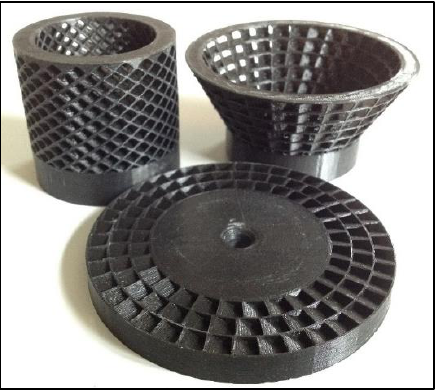
Figure 8. Mesh turbine impeller prototypes: on the left in the background - a cylindrical centrifugal turbine, in the foreground in the center - an axial disk turbine, on the right in the background - a conical centrifugal turbine.